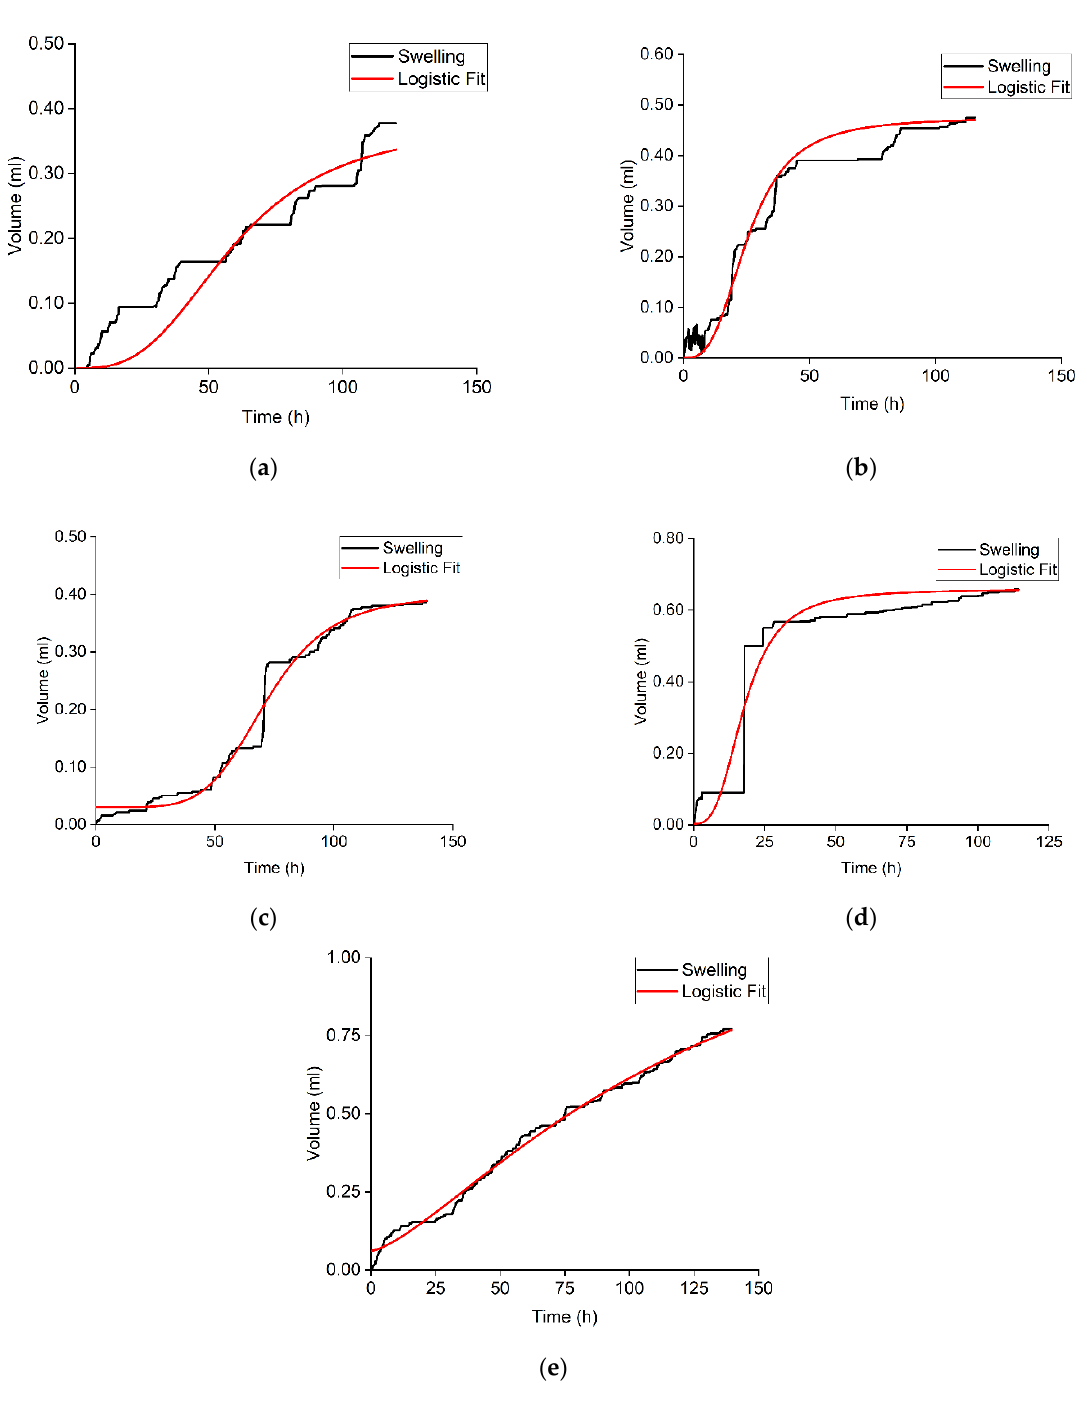
Figure 4. Sample rock volume change during swelling of the crushed rock samples in 0.2% NaOH solution in reservoir conditions, ( a – e ) for samples 1 – 5, respectively. Black curves show experimental data. Red curves show approximation of experimental data with logistic function (see Equation (6)) with parameters listed in Table 3. Table 3. Results of the crushed rock swelling experiments in the presence of 0.2% wt. NaOH solu- tion.